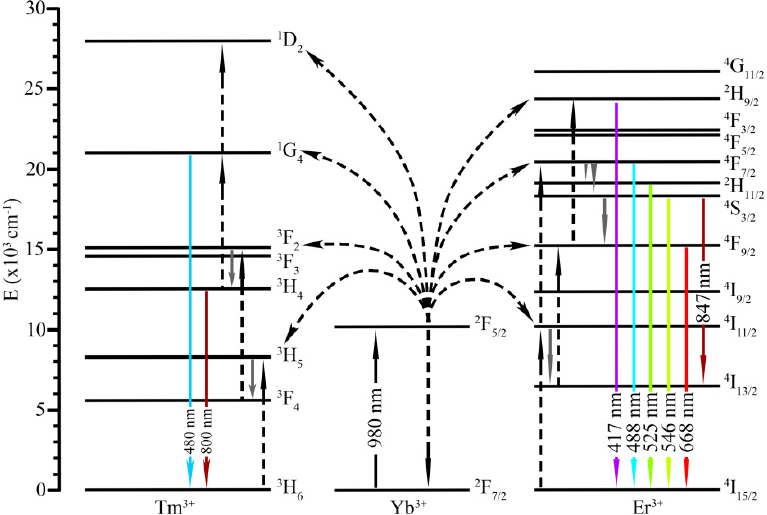
Fig. 2. Energy level diagram for energy transfer upconversion in NaYF 4 :Yb 3 þ , Tm 3 þ and NaYF 4 :Yb 3 þ , Er 3 þ . Dashed lines represent energy transfer excitation and relaxation, gray lines represent nonradiative relaxation, and colored lines represent radiative transitions. Energy levels taken from Carnall et al.